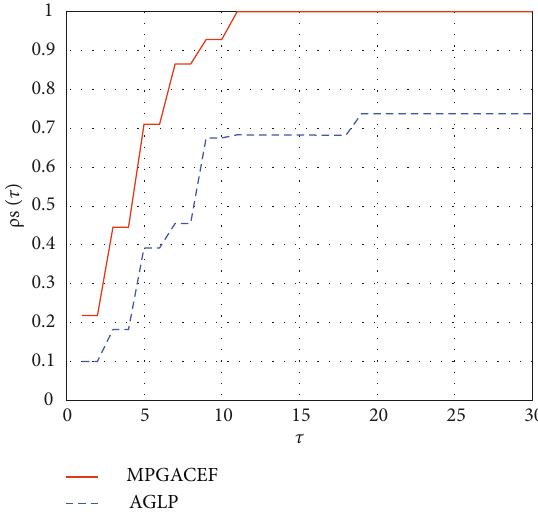
Figure 8: Performance of CPU Time for MPGACEF and AGLP under the condition of